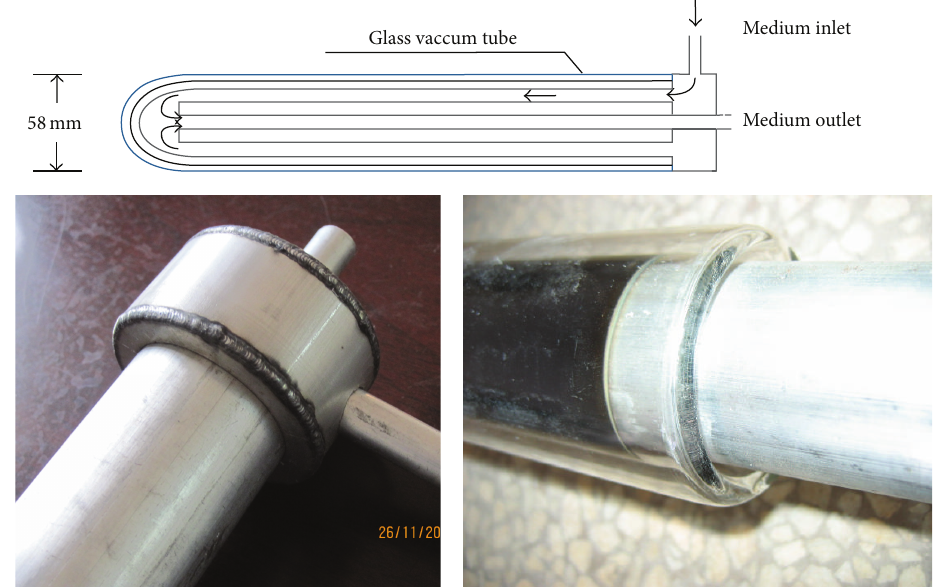
Figure 6: An aluminum concentric pipe receiver comprising of a glass evacuated tube.